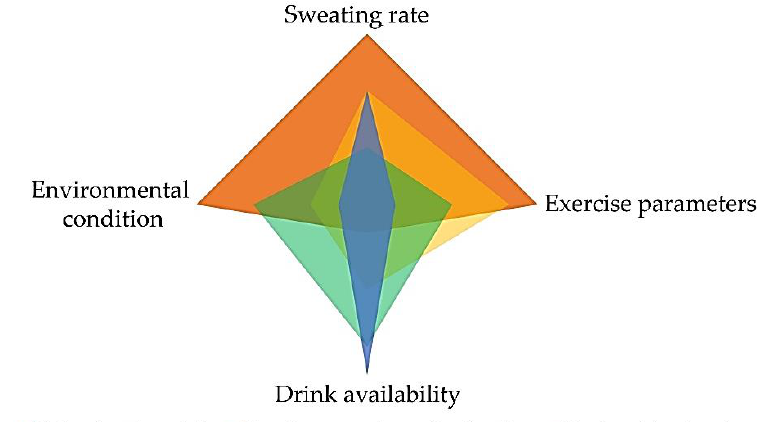
Figure 1. Multifactorial parameters of exercise and their effect on hydration. The diamond colours are representative of the hydration status (blue diamond = optimal hydration; green and yellow = tendency to hypohydration, unfavourable conditions; dark orange = dehydration risk), and they are matched with the diamond extremities, ac-